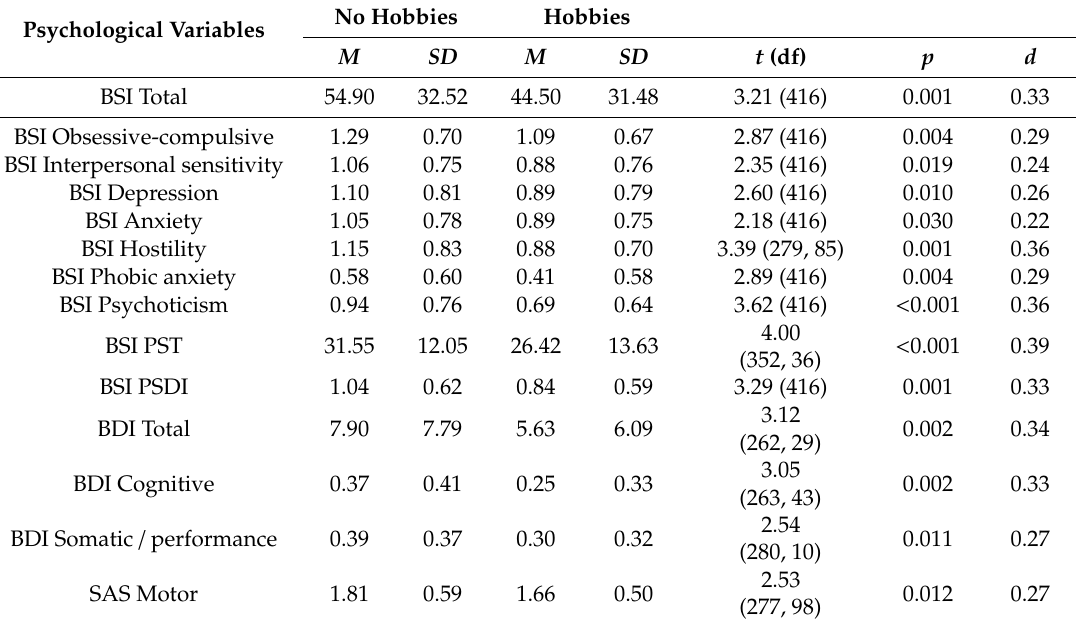
Table 8. Significant means di ff erences of